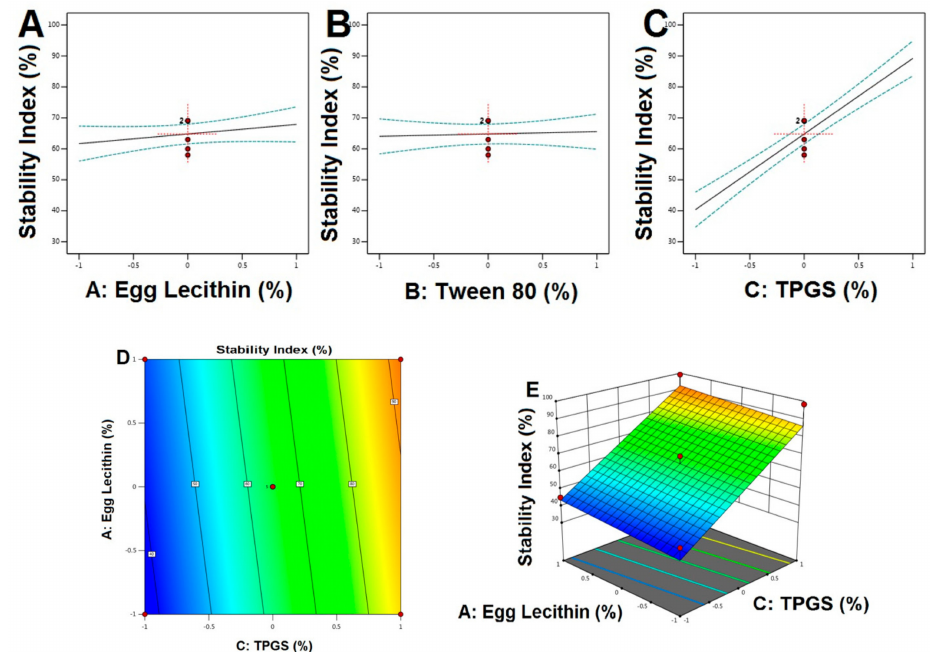
Figure 3. Main e ff ect diagram, contour, and 3-D response surface plots representing the e ff ect of studied variables on the stability index (Y3). ( A ). Main e ff ect diagram of Egg Lecithin (%) on stability index; ( B ). Main e ff ect diagram of Tween 80 (%) on stability index; ( C ). Main e ff ect diagram of TPGS (%) on stability index; ( D ). Contour Plot showing the e ff ect of Egg lecithin and TPGS on stability index; ( E ). 3-D Surface plot representing the e ff ects of the egg lecithin (%) and TPGS (%) on stability